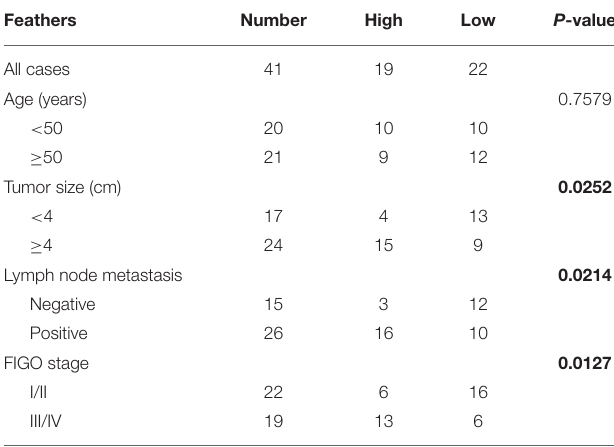
TABLE 1 | Association of LINC01969 expression with clinicopathological features of ovarian cancer. Feathers